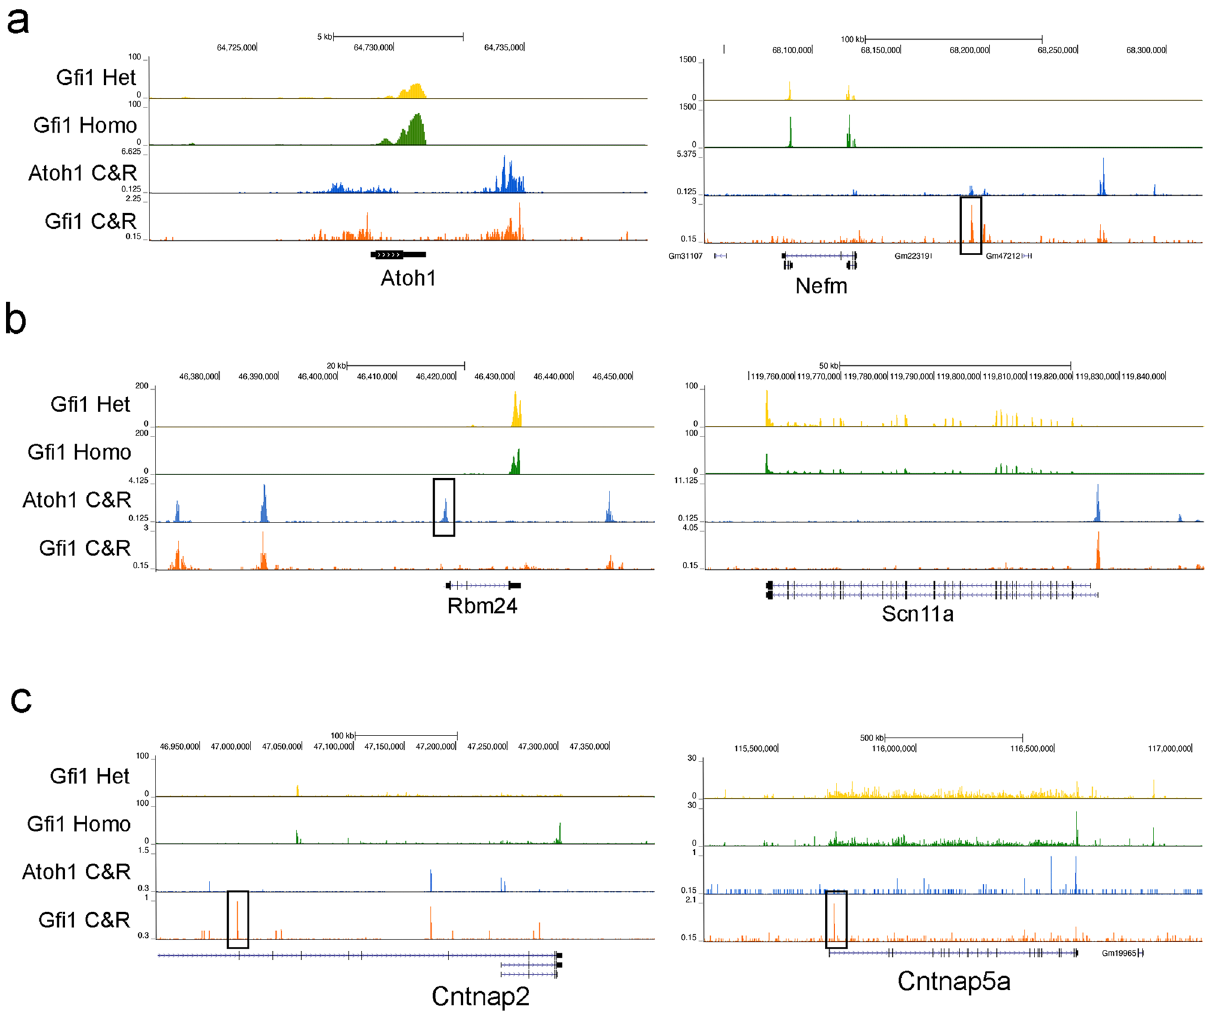
Figure 4. Examples of hair cell and non-hair cell enriched genes that are bound and regulated by GFI1 and ATOH1. ( a ) Genomic browser tracks of RNA-seq and CUT&RUN sequencing of two hair cell genes containing both ATOH1 and GFI1 binding sites that are up-regulated in the Gfi1 knockout: Atoh1 (Log 2 fold change in homozygous (homo) vs. heterozygous (het) Gfi1 mutants (LFC) = 0.42; False discovery rate (FDR) = 0.0492) and Nefm (LFC = 0.84; FDR = 0.000127). Box shows a peak that is uniquely bound by GFI1. ( b ) Genomic browser tracks of RNA-seq and CUT&RUN sequencing of two hair cell genes containing both ATOH1 and GFI1 binding sites that are down-regulated in the Gfi1 knockout: Rbm24 (LFC = − 0.85; FDR = 5.25E−07) and Scn11a (LFC = − 0.5; FDR = 0.00245). Box shows a peak that is uniquely bound by ATOH1. ( c ) Genomic browser tracks of RNA-seq and CUT&RUN sequencing of neuronal (non-hair cell) genes containing both ATOH1 and GFI1 binding sites that are upregulated in the Gfi1 knockout: Cntnap2 (LFC = 2.59; FDR = 3.79E−32) and Cntnap5a (LFC = 0.79; FDR = 6.23E−05). Boxes show peaks that are uniquely bound by